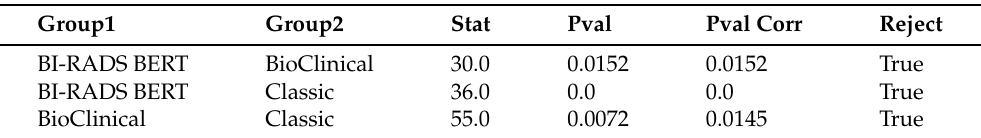
Table A15. Bonferonni-corrected McNemar test results for field extraction with no section segmenta- tion of BPE.